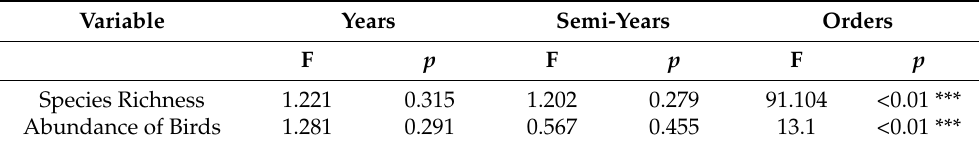
Table 2. Effects of years, semi-years and orders on species richness and abundance of birds. Variable Years Orders F p F Species Richness Abundance of Birds